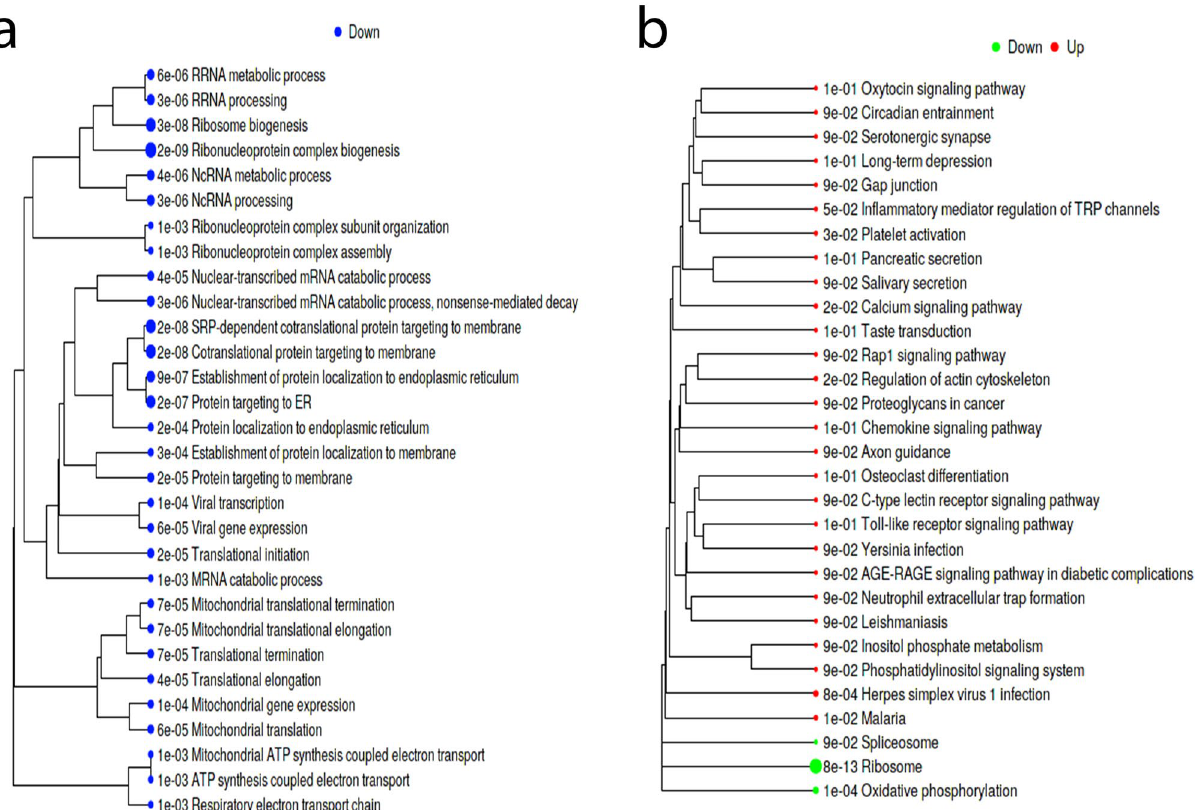
Figure 5. Pathway analysis reveals high DMD expression downregulates biological processes related to ribosome biogenesis. iDEP was used to conduct pathway analysis using the generally applicable gene set enrichment (GAGE) method and the genes were annotated according to GO biological processes ( a ) or with Kyoto Encyclopaedia of Genes and Genomes (KEGG, b ) 31 . The size of the dot corresponds to the adjusted P